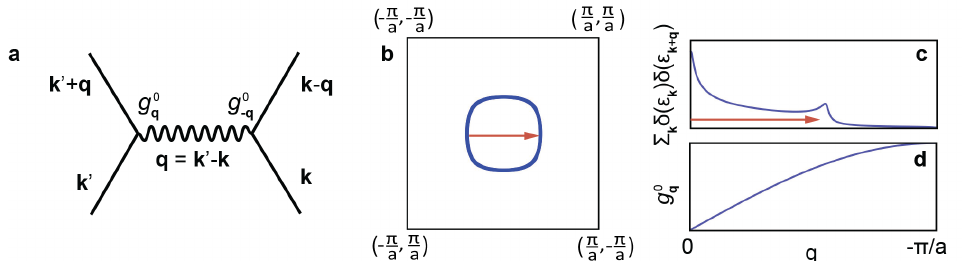
Figure 1: Electron-phonon interaction and the electron-phonon coupling parameter λ . a , Di- agrammatic representation of the coupling between electrons with momentum k , k (cid:48) through the exchange of a phonon with momentum q and interaction matrix element g 0 = g 0 dent only on q , g 0 ). b , Due to the kinematic constraint (Eq. (1)), only scattering vectors q kq connecting the Fermi surface points are relevant (red arrow). c , Kinematic constraint along a high-symmetry direction. d , The structure of the interaction matrix element determines what kinematic constraints lead to a high electron-phonon interaction λ ; in the example here a large Fermi surface is beneficial.